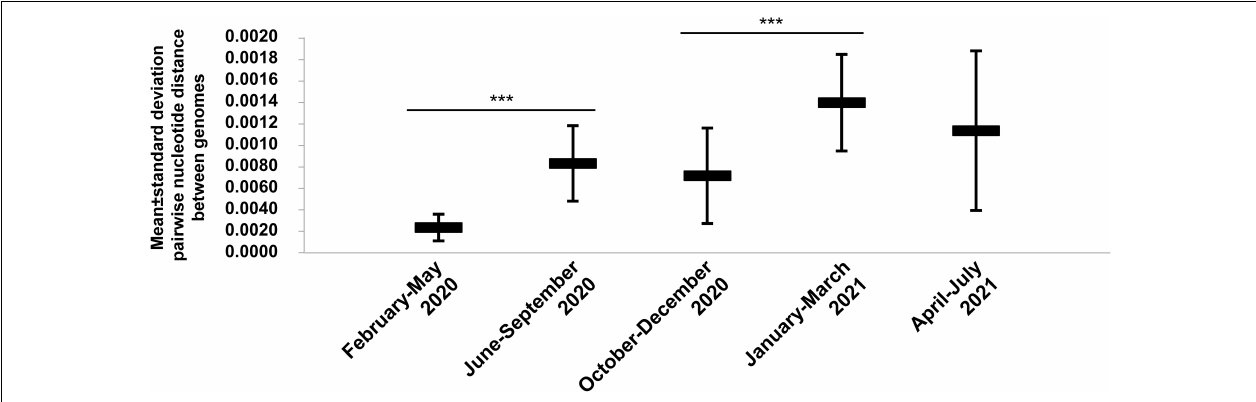
FIGURE 3 | Chronological distribution of mean ( ± standard deviation) pairwise genetic distances according to time periods for SARS-CoV-2 genomes obtained from patients SARS-CoV-2-diagnosed at IHU Méditerranée Infection, Marseille. *** p < 10 − 3 .